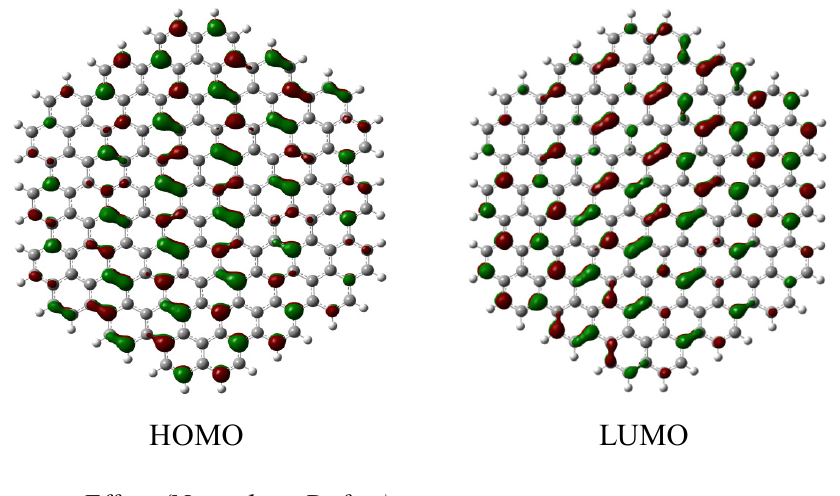
Figure 3. Calculated HOMO and LUMO of H-terminated